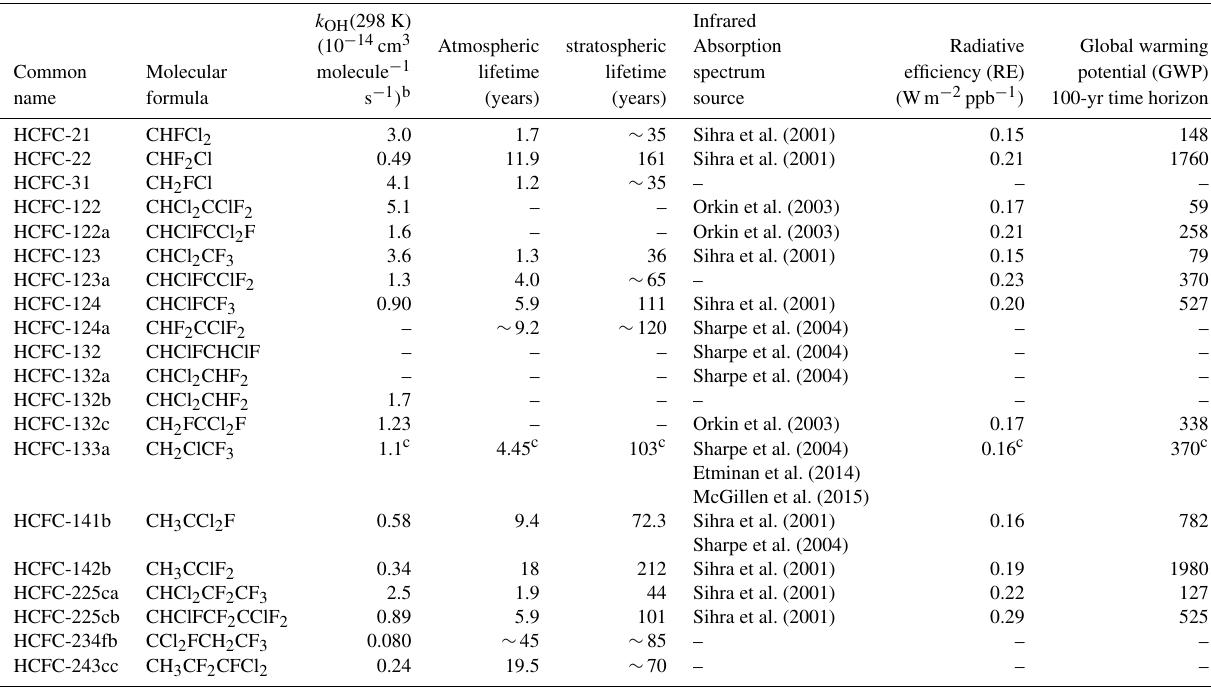
Table 1. Summary of hydrochlorofluorocarbon (HCFC) parameters in the training dataset a .